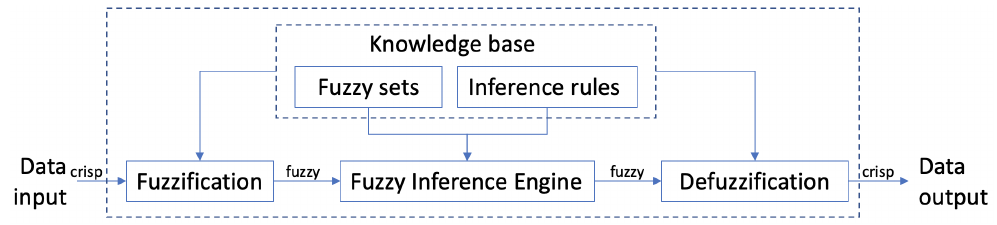
Figure 2. Architecture of a fuzzy inference